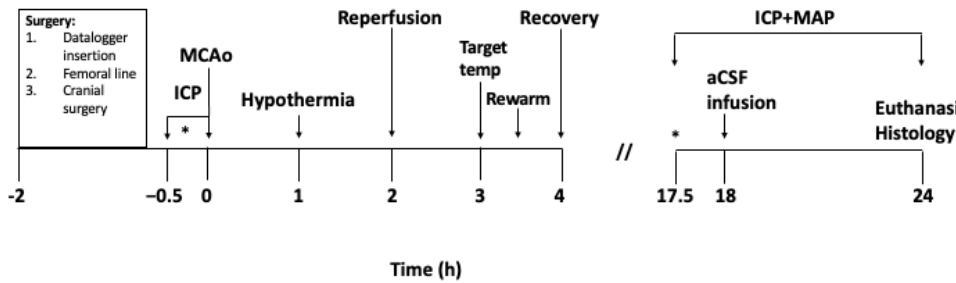
Figure 1. Experimental protocol in hours. MAP = Mean arterial pressure. The asterisk (*) indicates the period of baseline ICP readings for 30 min.